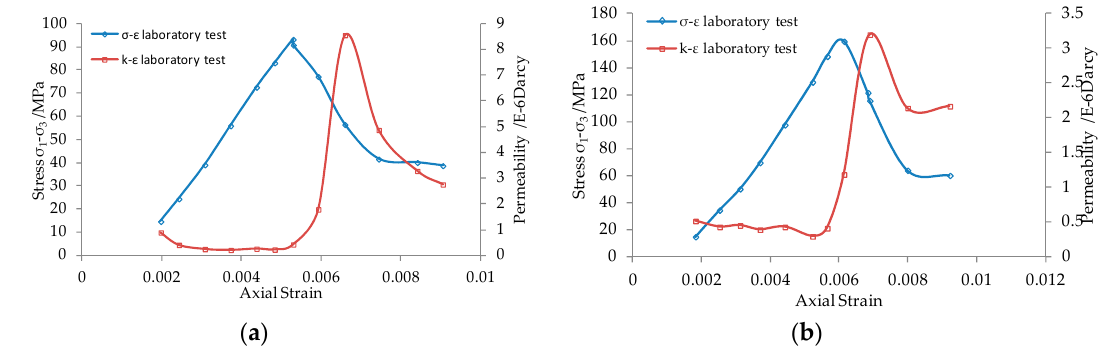
Figure 4. Stress-strain-permeability curve of rock sample; ( a ) Sample F-2; ( b ) Sample E-3.